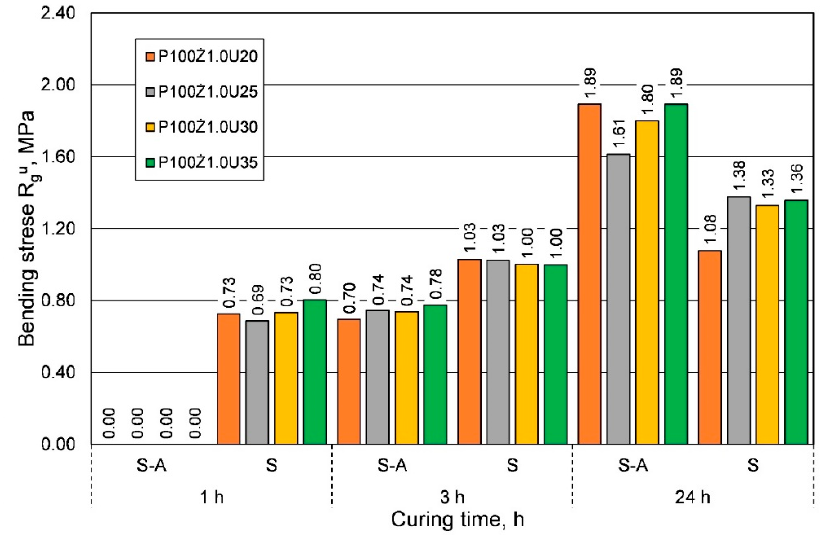
Figure 10. Bending strength R u g of molding sand based on fresh chromite sand, depending on weather conditions, for different amounts of added hardener.